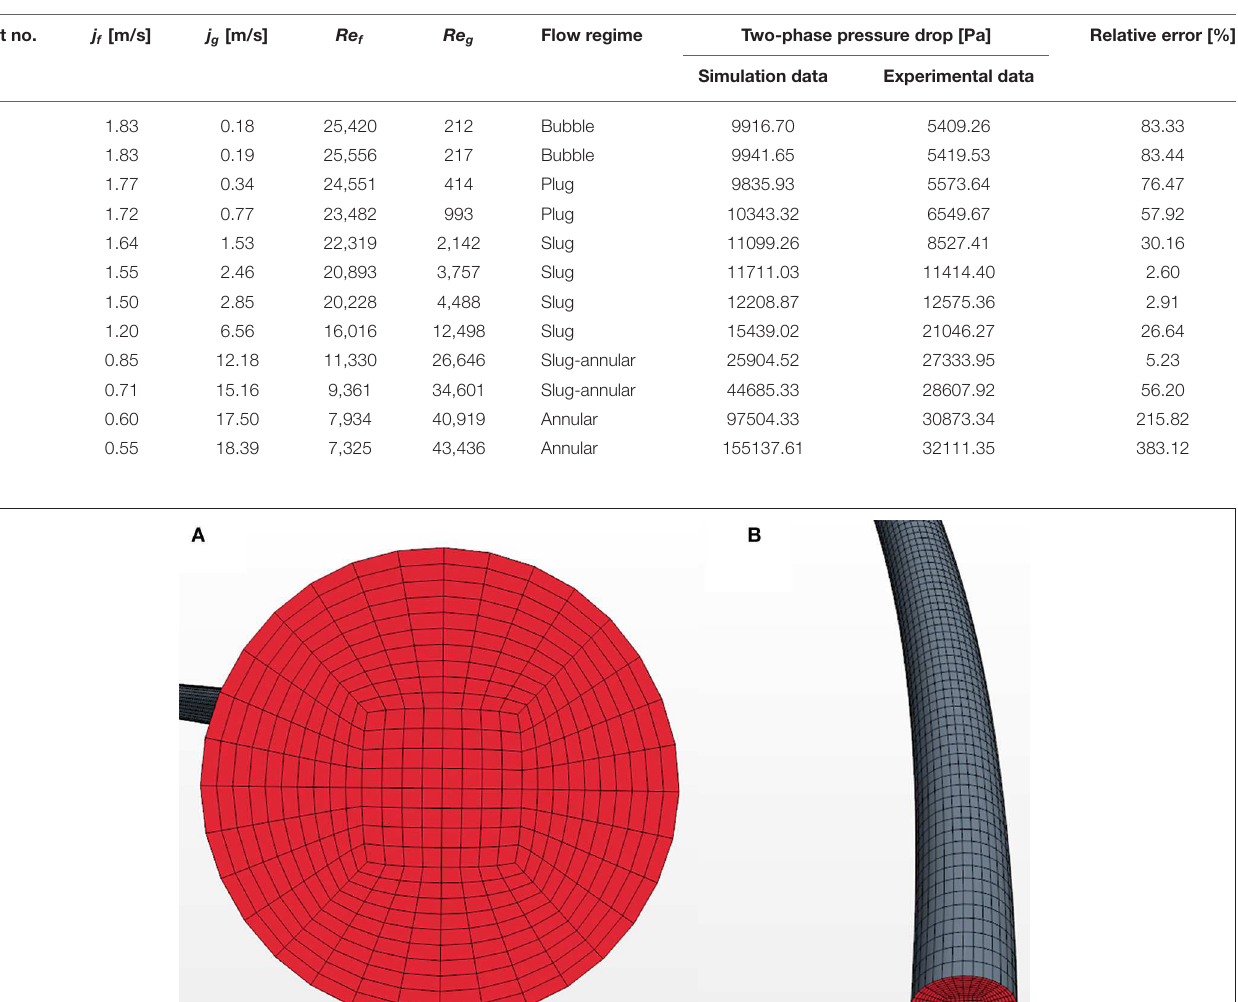
Frontiers in Energy Research |